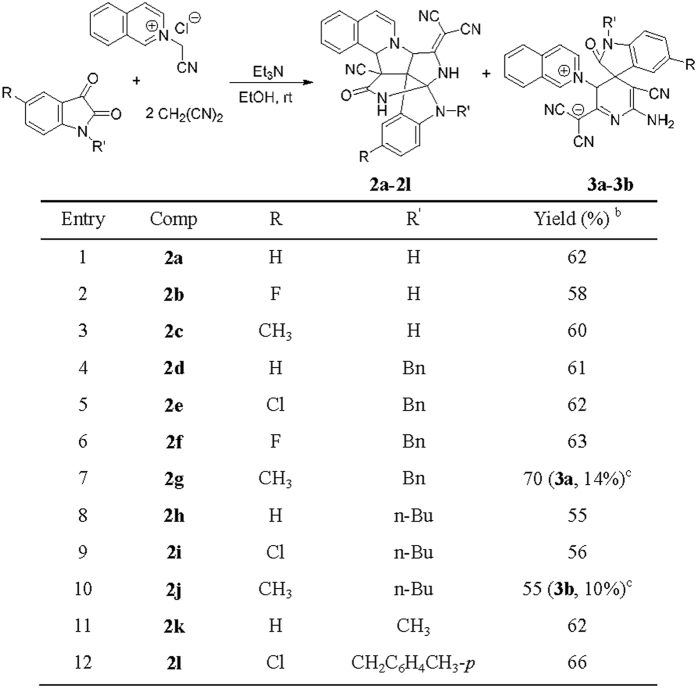
Synthesis of indolo[2″,3″:2′,3′]pyrrolo[3′,4′:4,5]pyrrolo[2,1-a]isoquinolines 2a-2la.